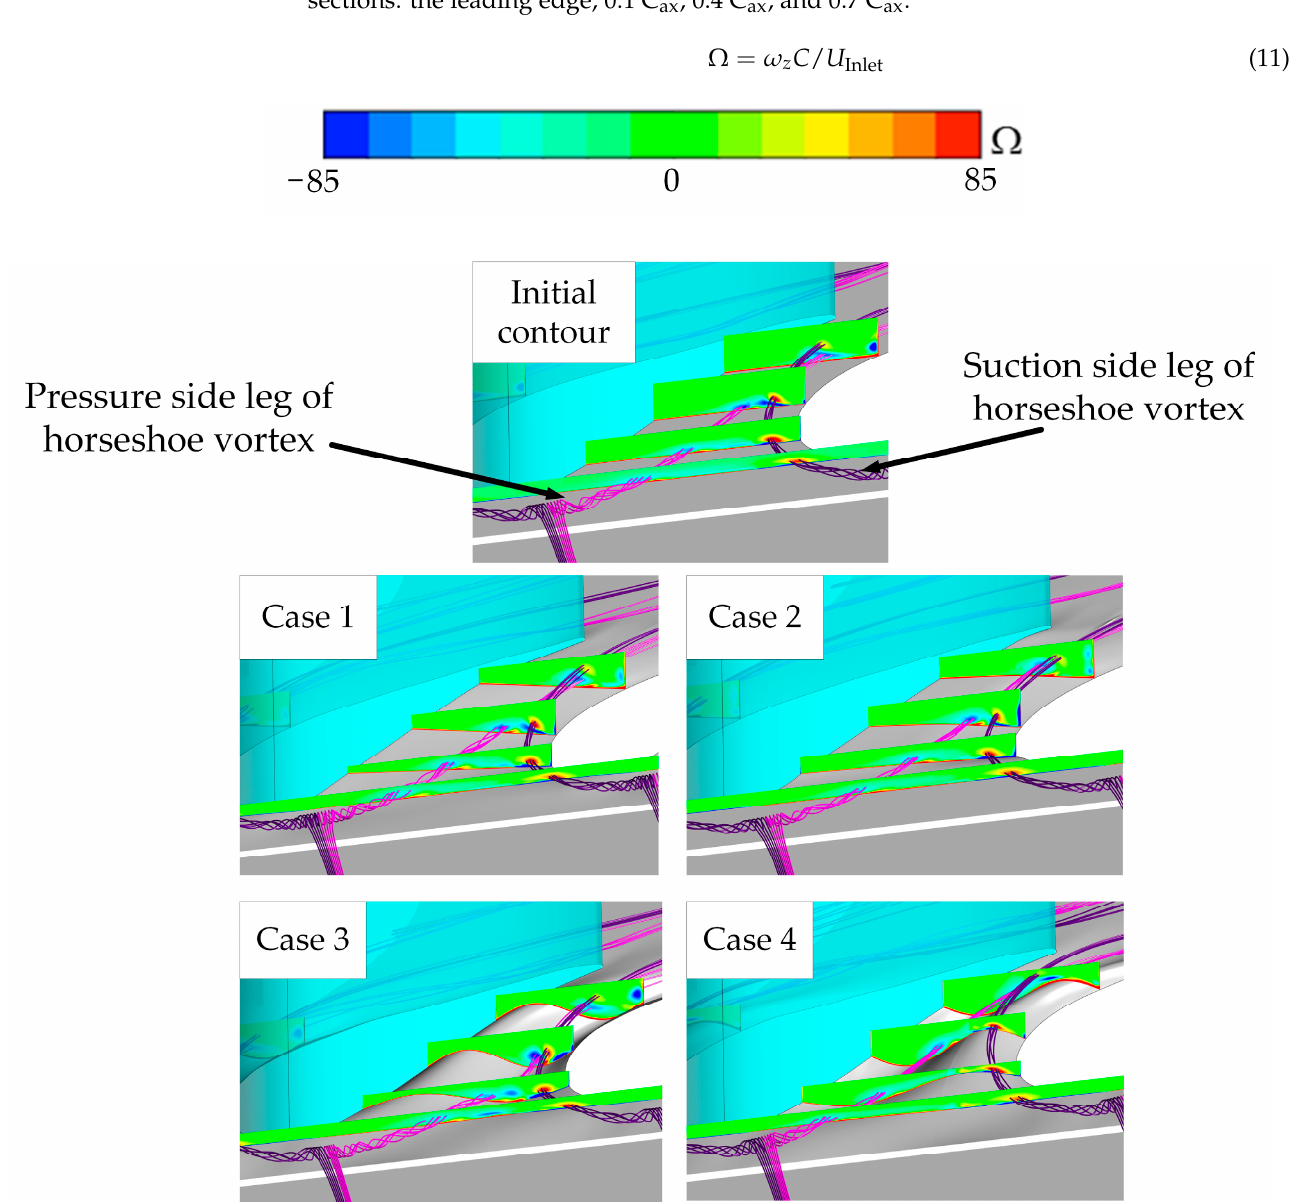
Figure 8. Vorticity distributions at LE, 0.1 C ax , 0.4C ax , and 0.7 C ax sections. The consequences portray how the NECs could hinder the development of the horse- shoe vortex. In the section of the leading edge, there is no noticeable difference in the horseshoe vortex. At the 0.4 C ax and 0.7 C ax cross-sections, Cases 1, 2, and 4 show the attenuation of the passage vortex loss core. Among them, Cases 1 and 2 inhibit the